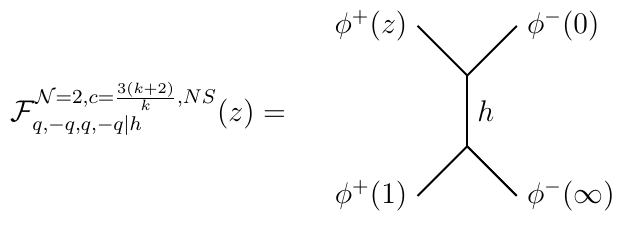
Figure 2 . The chiral-anti-chiral c = 3( k +2) chiral/anti-chiral primaries (cid:30) (cid:6) of weight j q j U(1) R neutral non-BPS primary of weight h